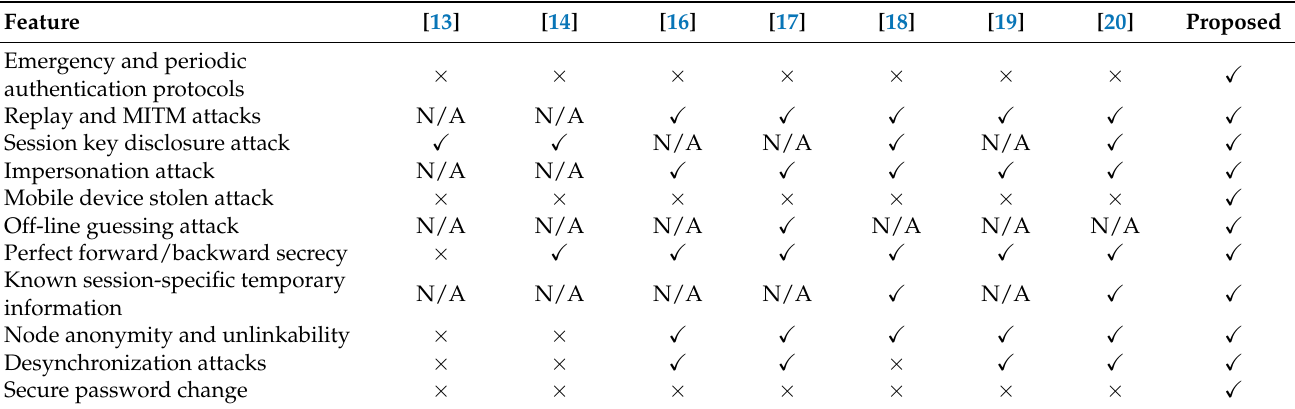
Table 2. Security features